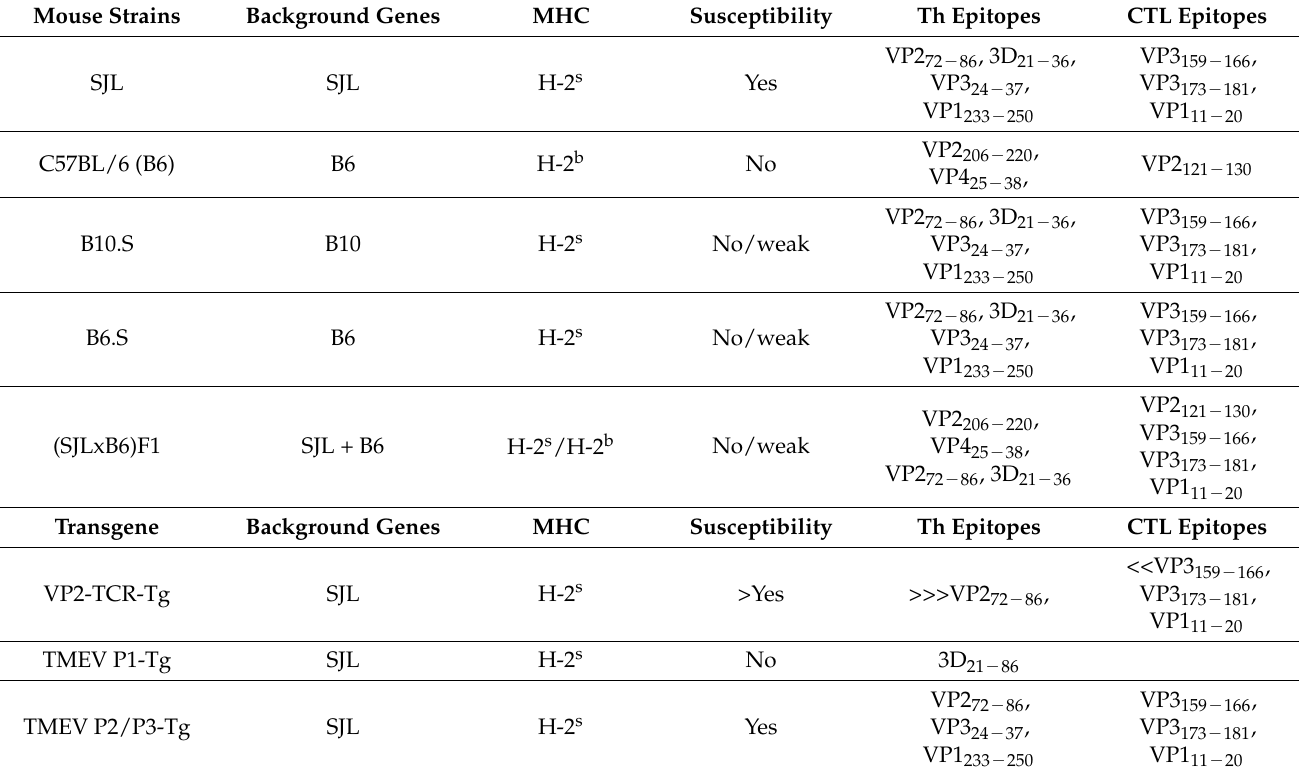
Table 1. Properties of major mouse strains and transgenic mice used in this